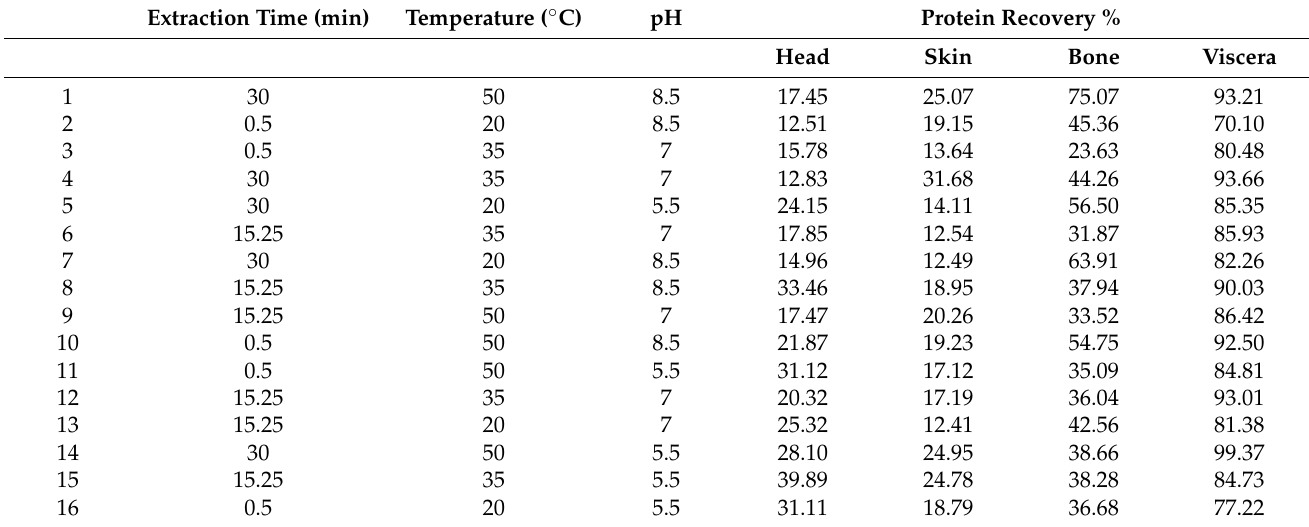
Table 4. Percentage of protein recovered from sea bass side streams extracted using UAE at different extraction times (min), temperature ( ◦ C), and